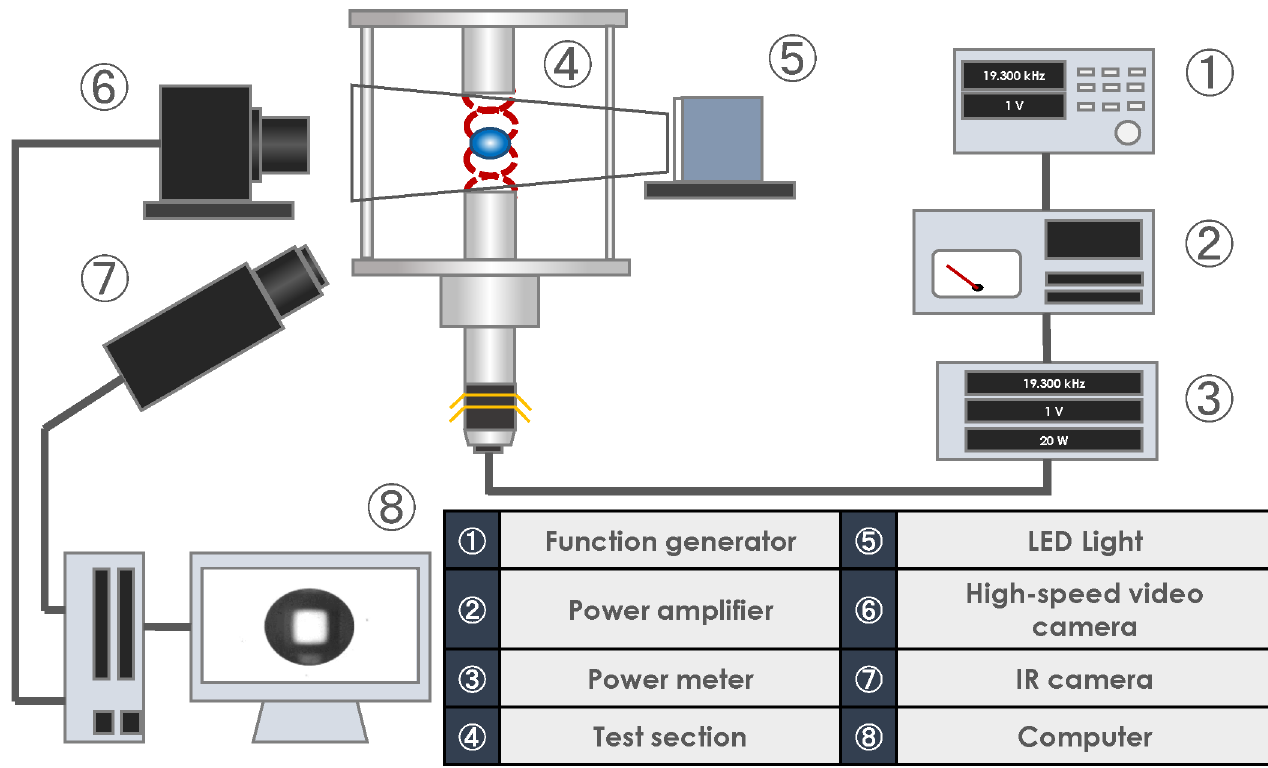
Fig 1. Schematic diagram of the experimental